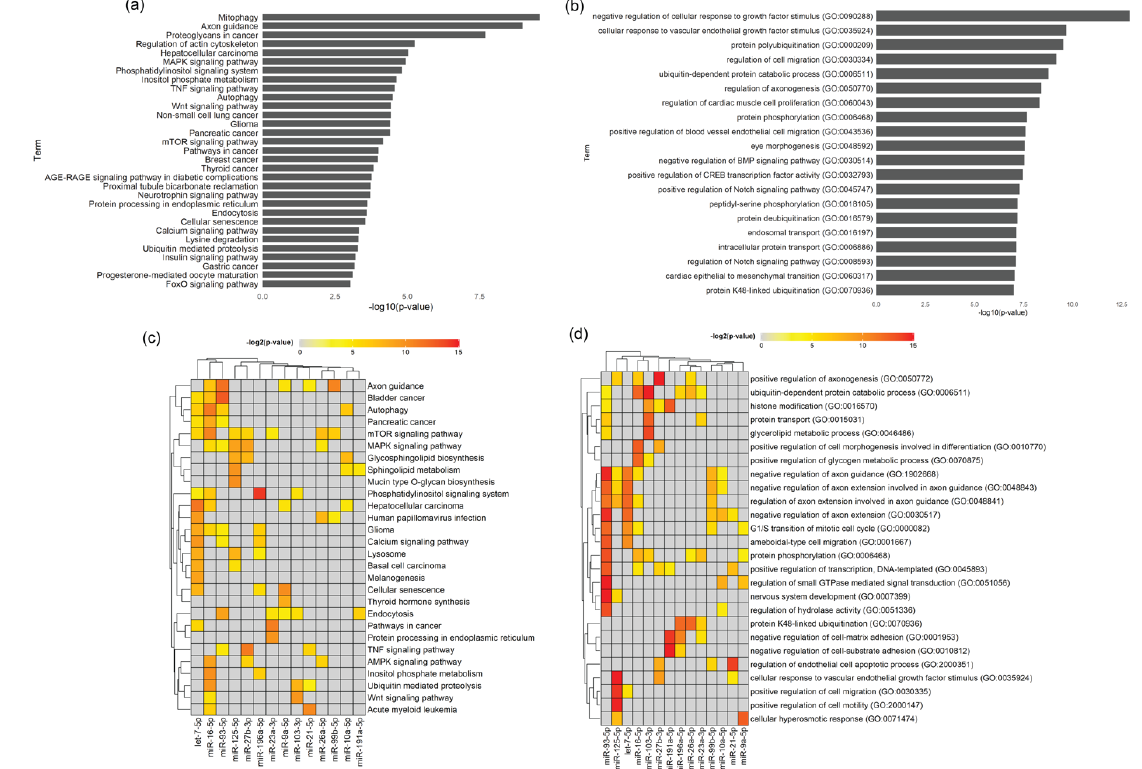
Figure 7. WT Schwann cell EV Pathway and Process analysis. ( a ) Pathway analysis for all genes predicted to be targets of 3 or more miRNAs. Hits from KEGG pathways with p -value < 0.05. Cancer hits were removed. ( b ) Pathway analysis for all genes predicted to be targets of 3 or more miRNAs. The top 20 hits from Gene Ontology Biological Process. ( c ) Pathway analysis for predicted targets of each individual miRNA. The 30 most significant hits from KEGG pathways are shown. The heatmap shows the level of significance — red being the most significant, grey meaning not significant. ( d ) Process analysis for predicted targets of each individual miRNA. The 30 most significant hits from Gene Ontology Biological Process are shown. The heatmap shows the level of significance — red being the most significant and grey representing non significance.